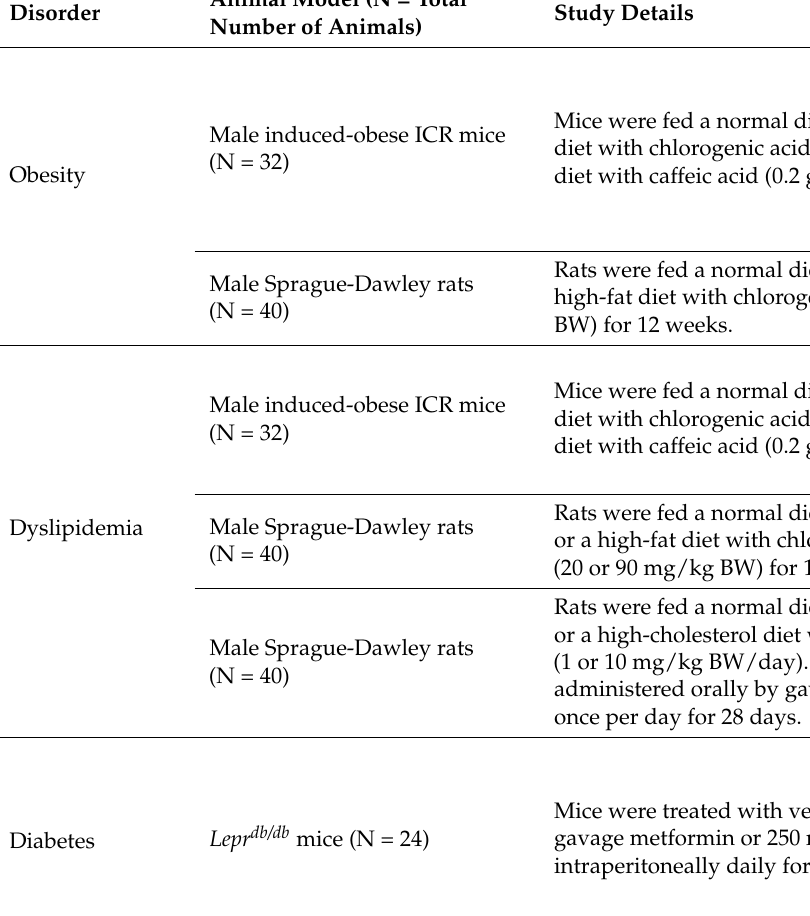
Table 1. In vivo studies evaluating the effect of chlorogenic acid on the prevention and treatment of metabolic syndrome and associated disorders.